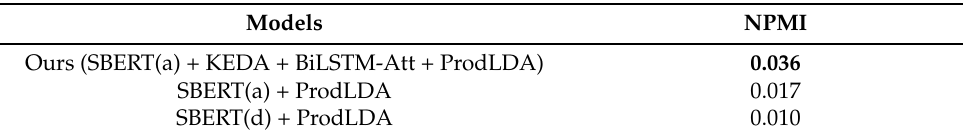
Table 5. NPMI values under ablation